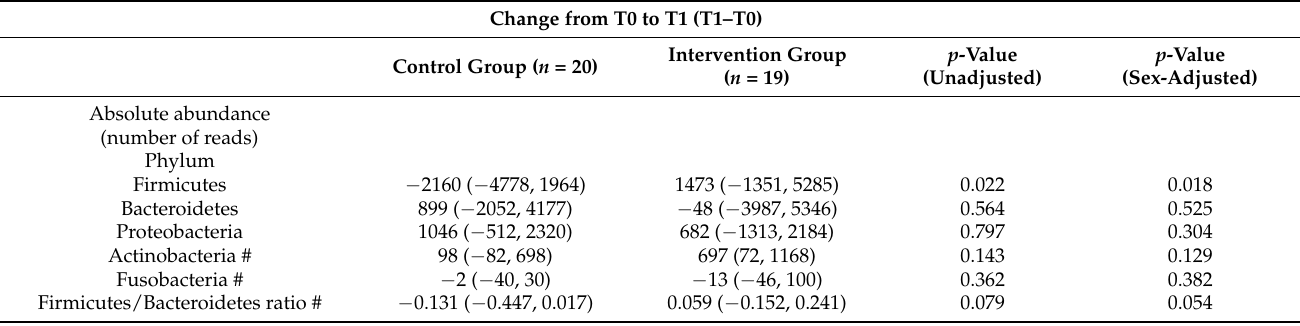
Control Group ( n = 20)